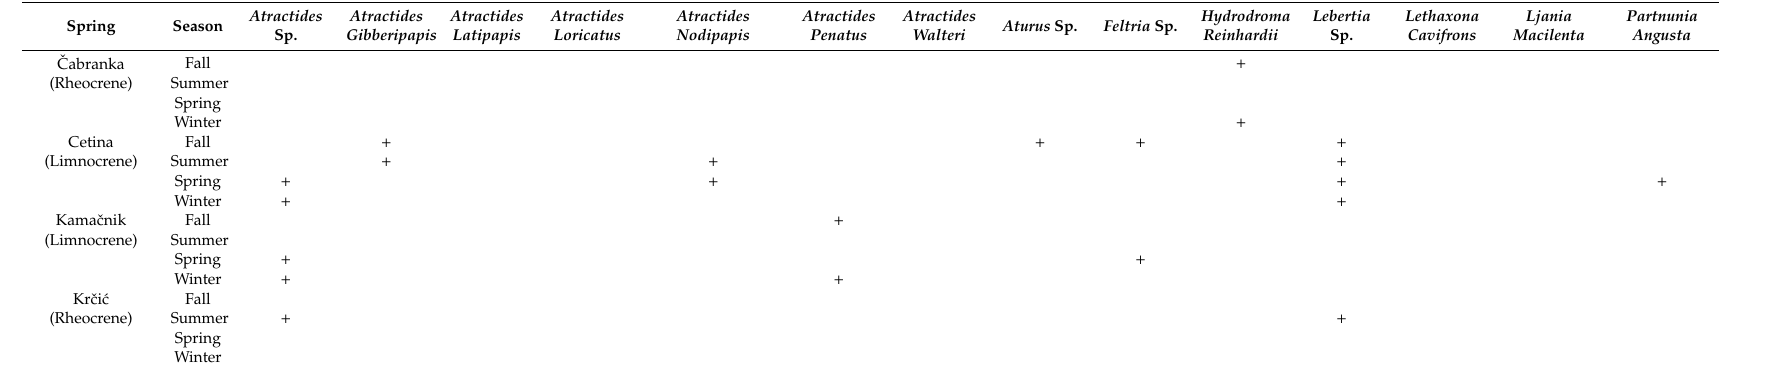
Table A3. Seasonal water mite taxa occurrence in the studied limnocrenes and